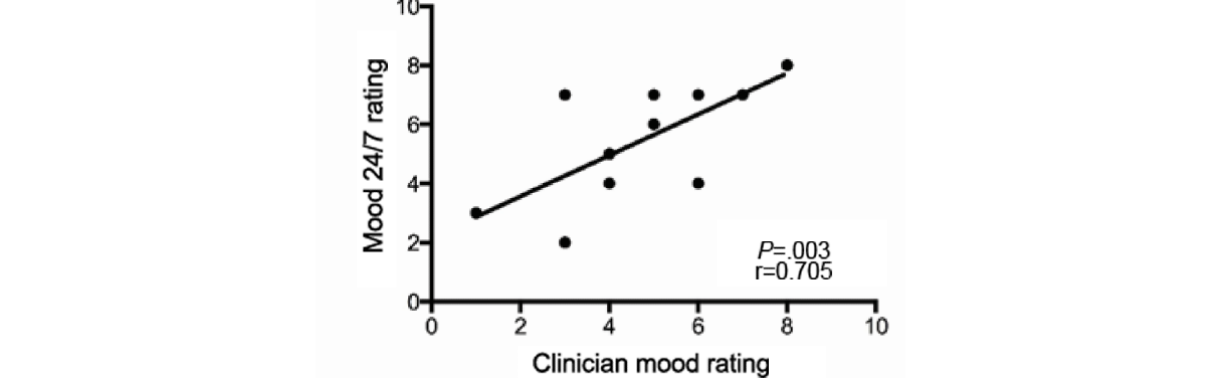
Figure 2. Validation of Mood 24/7. Both the mood ratings assigned by the clinician and mood determined by a standard mood assessment test correlate with patients’Mood 24/7 self-assessment rating. Clinician mood ratings positively correlated with Mood 24/7 rating ( P